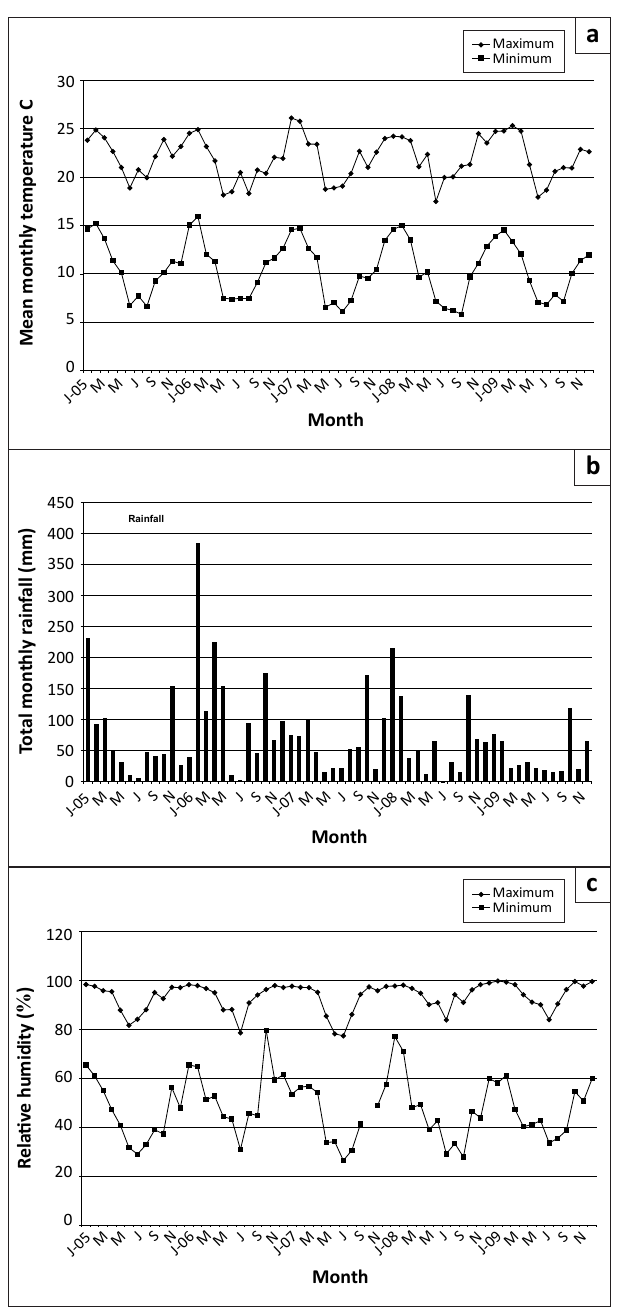
FIGURE 1: (a) Mean monthly maximum and minimum temperatures, (b) monthly rainfall and (c) mean monthly relative humidity at Döhne. TABLE 1: Species composition of ticks questing for hosts from the pastures grazed by Bonsmara or Nguni cattle at Döhne or by Bonsmara cattle at Campagna (2005–2009). Tick species Total number of questing ticks